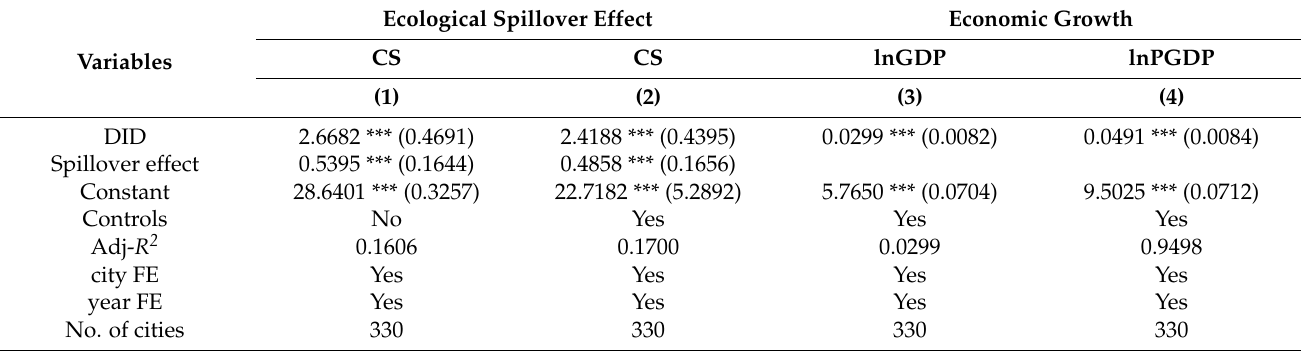
Table 8. Results of expandability